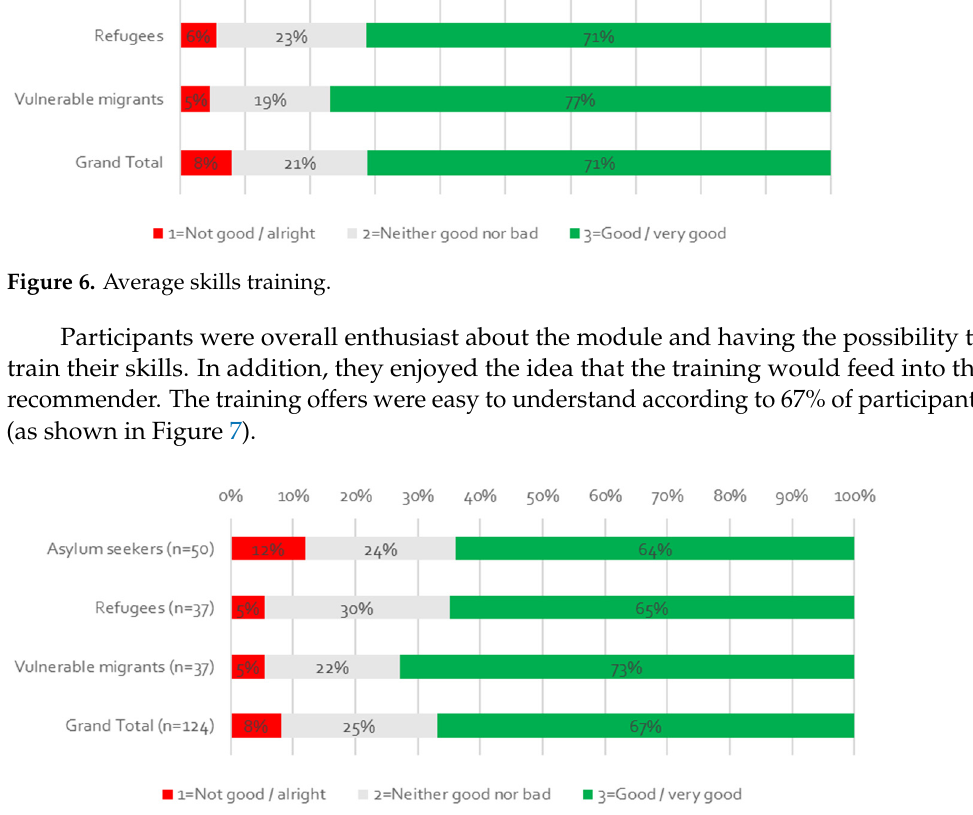
Figure 7. The responses to the prompt “The level of easiness to go through the training offers was...”.